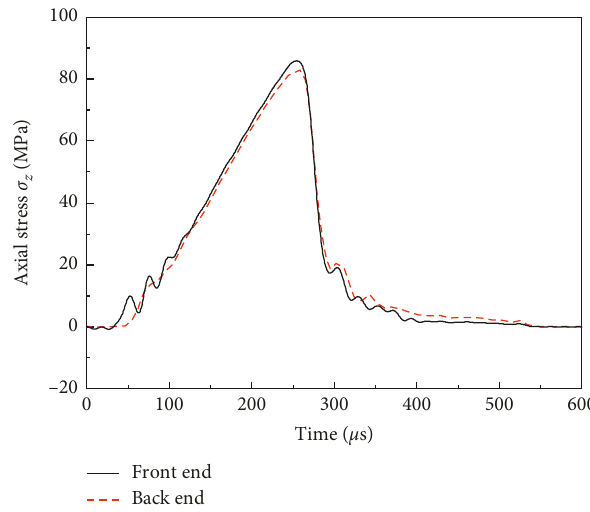
Figure 6: Dynamic stress equilibrium in the sand sample (test group number: